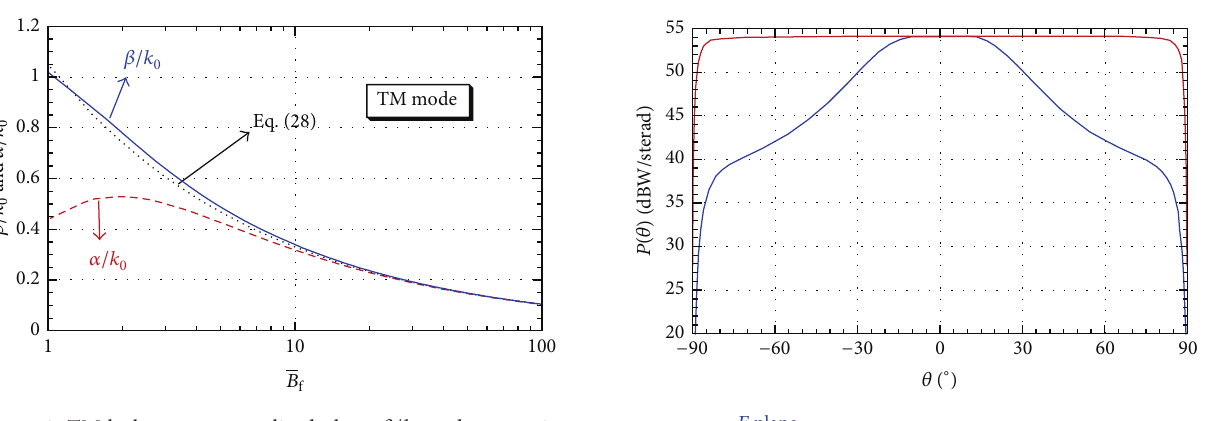
Figure 3: TM leaky wave normalized phase 𝛽/𝑘 0 and attenuation 𝛼/𝑘 0 constants as a function of the normalized susceptance representing the ferroelectric thin film for the proposed antenna. Parameters: 𝜀 𝑟1 = 2.2 ; 𝑓 = 1 GHz; for each value of 𝐵 𝑓 , the thickness 𝑏 of the slab has been calculated according to the optimization condition in (6).